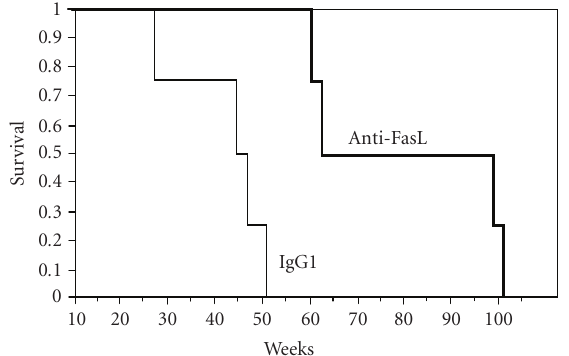
Figure 4: Anti-FasL treatment prolongs survival in SIVmac- infected macaques. The fraction of surviving animals is plotted for up to 102 weeks after SIVmac239 infection. The thin line shows the fraction of animals surviving after control IgG treatment and SIV infection. All control animals died by 52 weeks after SIV infection. The thick line shows the e ff ect of anti-FasL treatment (anti-FasL) in extending survival times. None of the anti-FasL-treated animals had died before 60 weeks after SIV infection, and the last surviving an- imal lived until 102 weeks. The two longest-lived animals also had lowest viral loads (Figure